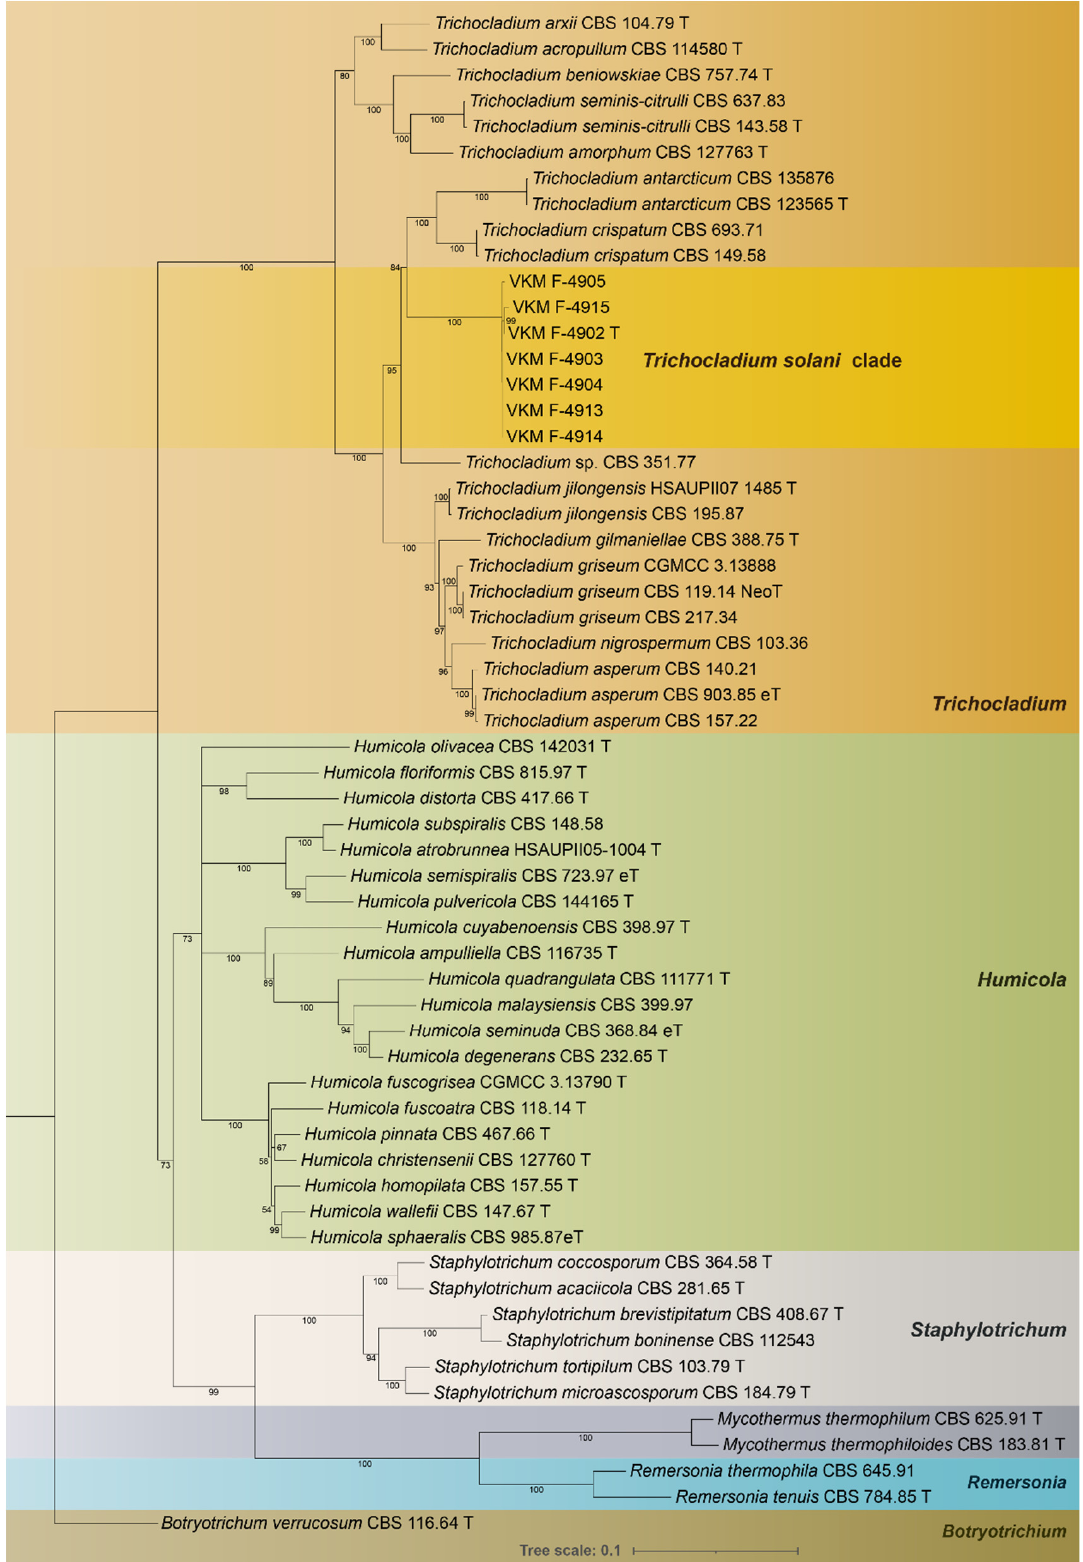
Figure 1. Phylogenetic tree inferred from a maximum-likelihood analysis of the concatenated align- ment including the partial rpb2 gene region, partial tub2 gene region, and ITS region. The confidence values are indicated at the branches. The scale bar shows the expected number of changes per